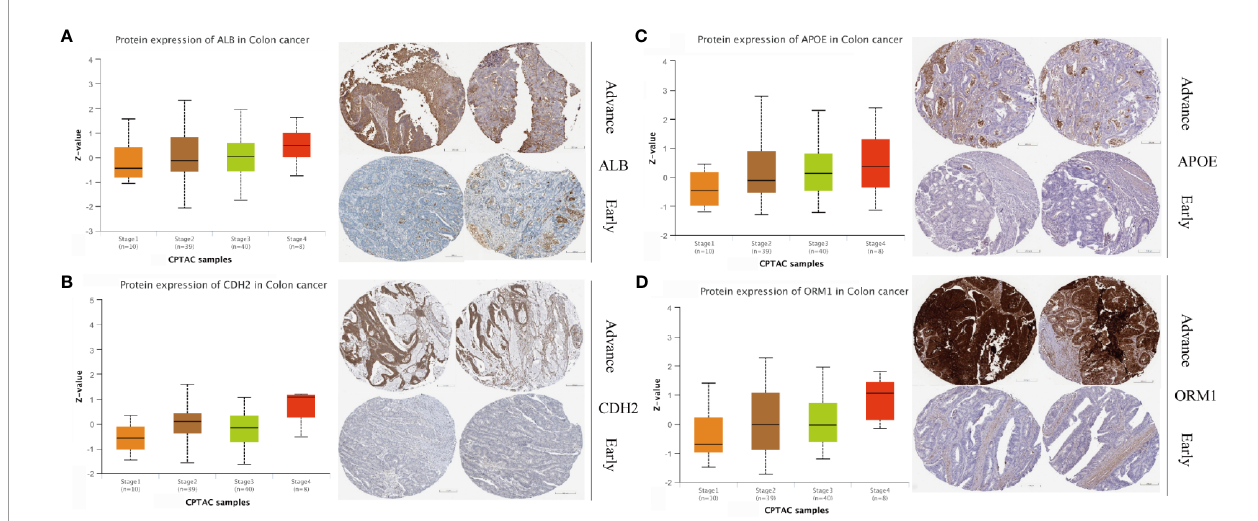
FIGURE 7 | Protein expression level in different stages of colon cancer. Protein expression and immunohistochemical images of (A) ALB, (B) CDH2, (C) APOE, and (D) ORM1. Data were extracted from UALCAN and Human Protein Atlas,